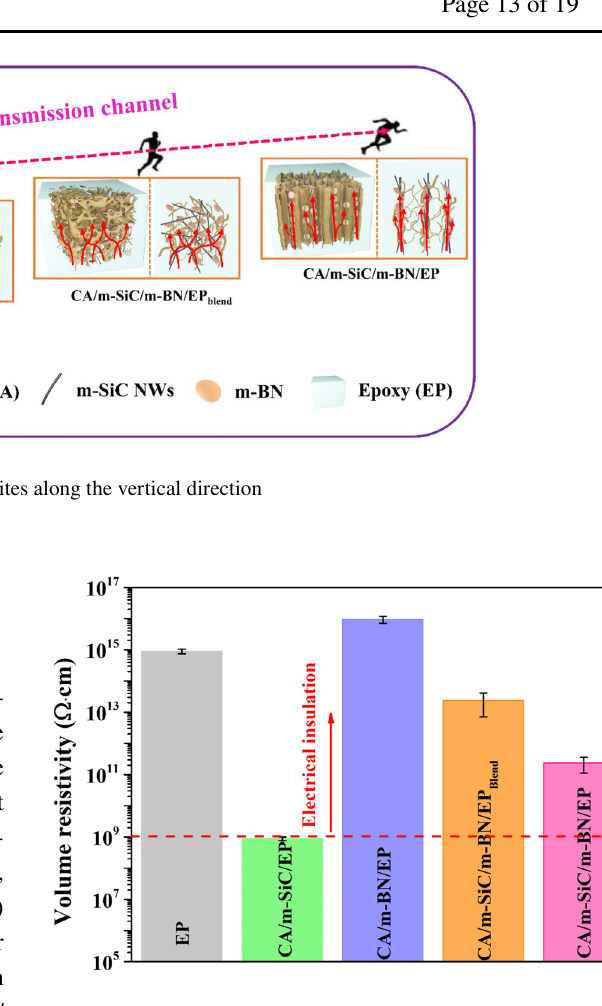
Fig. 9 The volume resistivity of pure EP and different EP‑based composites in the vertical